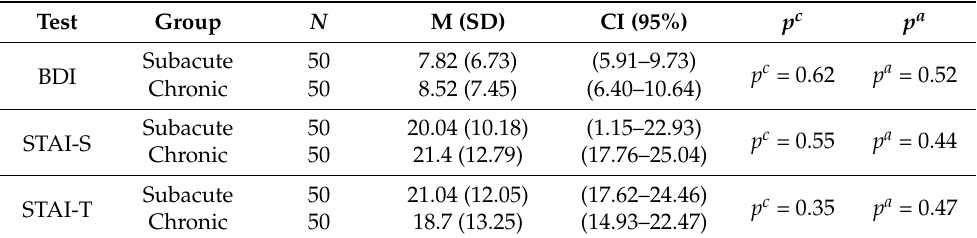
Table 3. Regression analysis of the anxiety scores (state-trait) and depression, adjusted by level of injury and psychotropic use.